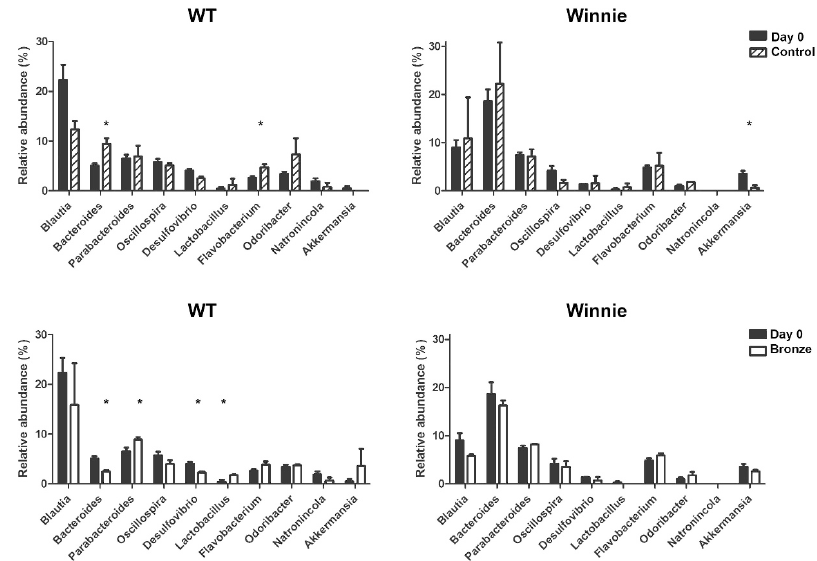
Figure 5. The Bronze-enriched diet affected the fecal bacterial genera of both WT and Winnie mice. Relative abundance (%) of total (16S rRNA) bacteria, found at the genus level in the fecal samples of WT and Winnie mice at T0 (Day 0, black bars) and after two weeks of Bronze (white bars) or Control tomato (striped bars) diet.